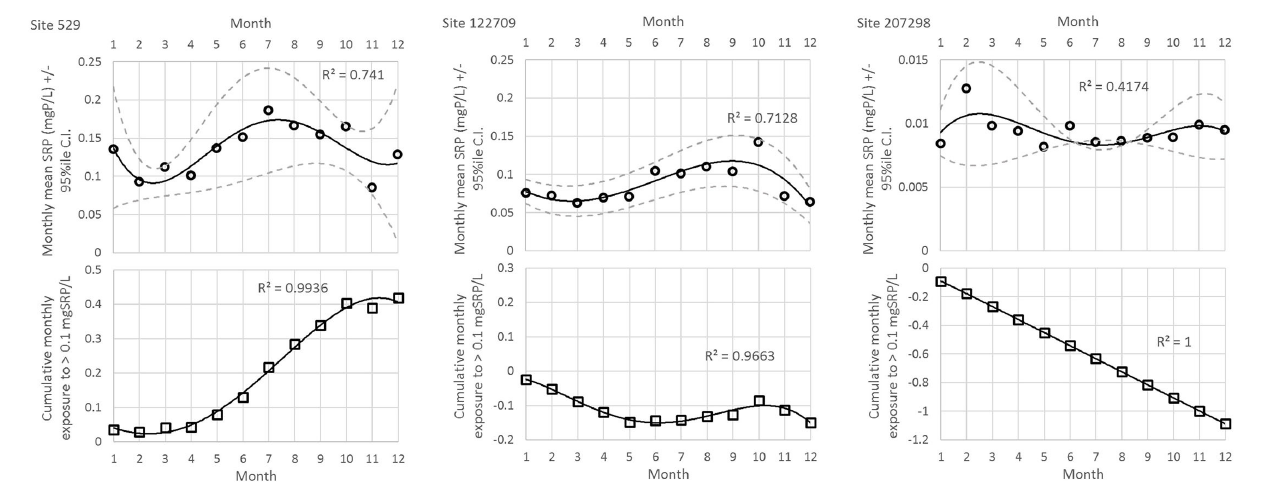
FIGURE 3 | Example types of SRP concentration—exposure plots for three contrasting